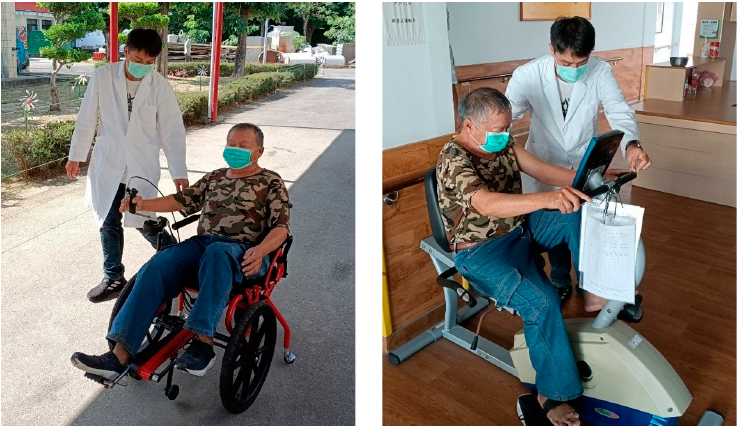
Figure 1. The scene of cycling wheelchair training ( left ) and the setting of aero bike test ( right